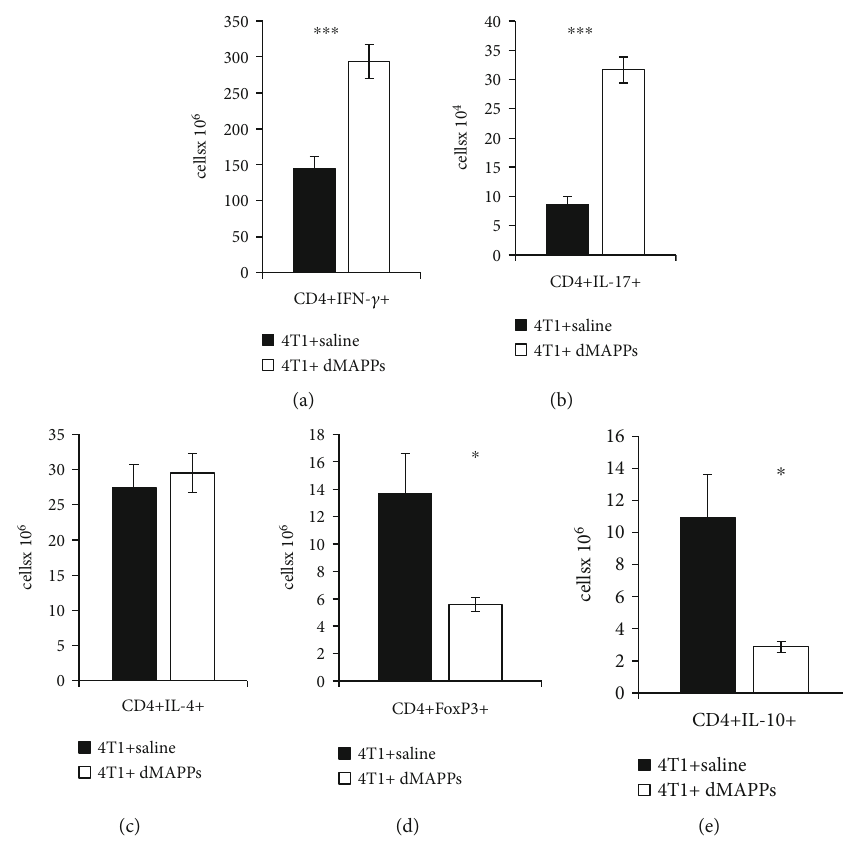
Figure 5: d-MAPPS increased antitumorigenic CD4+ Th1 and Th17 cells and decreased immunosuppressive T regulatory cells in the tumors of 4T1-treated mice. Total number of (a) IFN- γ -producing CD4+ Th1 cells, (b) IL-17-producing CD4+ Th17 cells, (c) IL-4- producing CD4+ Th2 cells, (d) IL-10-producing CD4+ T cells, and (e) FoxP3-expressing CD4+ Tregs in the tumors of 4T1+saline- treated (black bars) and 4T1+d-MAPPS-treated mice (white bars), as determined by the fl ow cytometry analysis and intracellular staining of tumor-in fi ltrated mononuclear cells. Data are presented as mean + / − SEM ( n = 16 mice/group; ∗ p < 0 : 05 ; ∗∗∗ p < 0 : 001